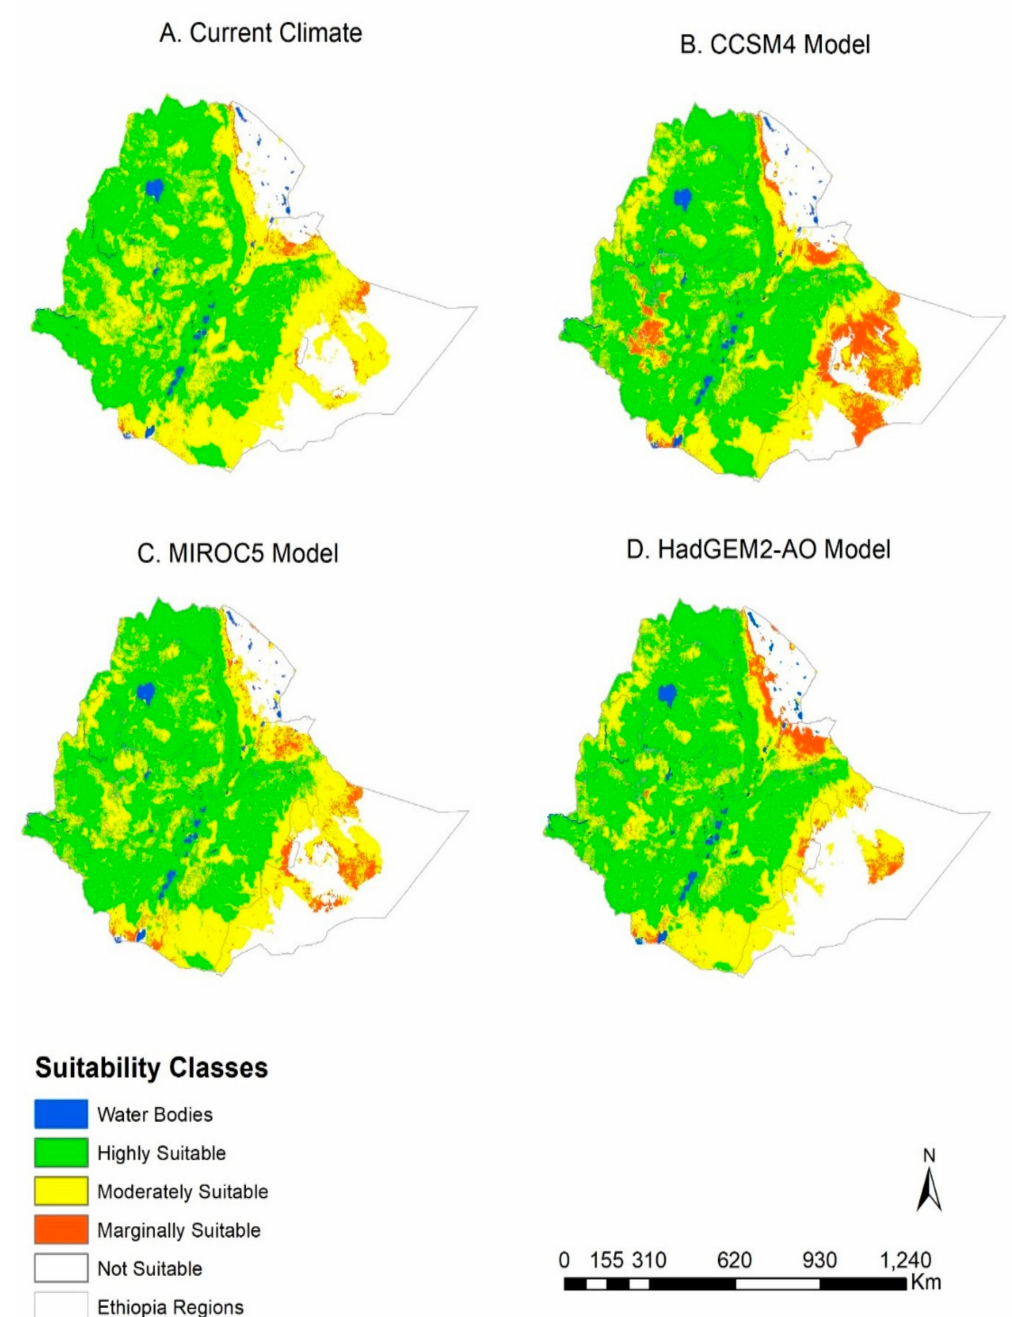
Figure 8. Alfalfa suitability classes (i.e., highly, moderately and marginally) under ( A ) current climate (1970–2000) and three global circulation models (( B ) CCSM4, ( C ) MIROC5, and ( D ) HadGEM2-AO) representing the 4.5 representative concentration pathway for the period of 2041–2060 in